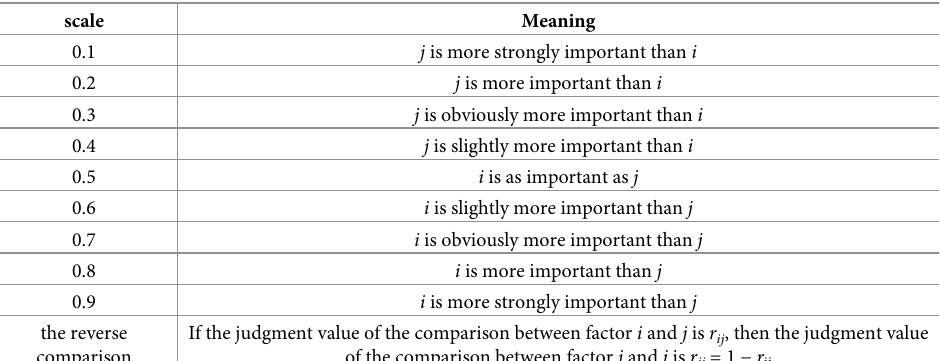
Table 2. (0.1–0.9) scale method